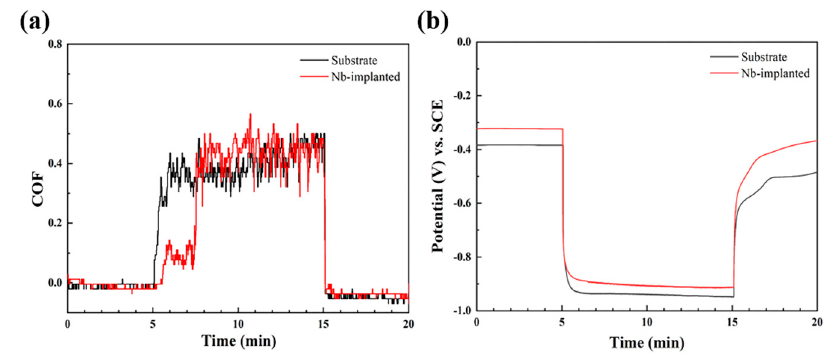
Figure 5. The variation of coe ffi cient of friction and open circuit potential of samples in Ringer’s: ( a ) coe ffi cient of friction; ( b ) open circuit potential.